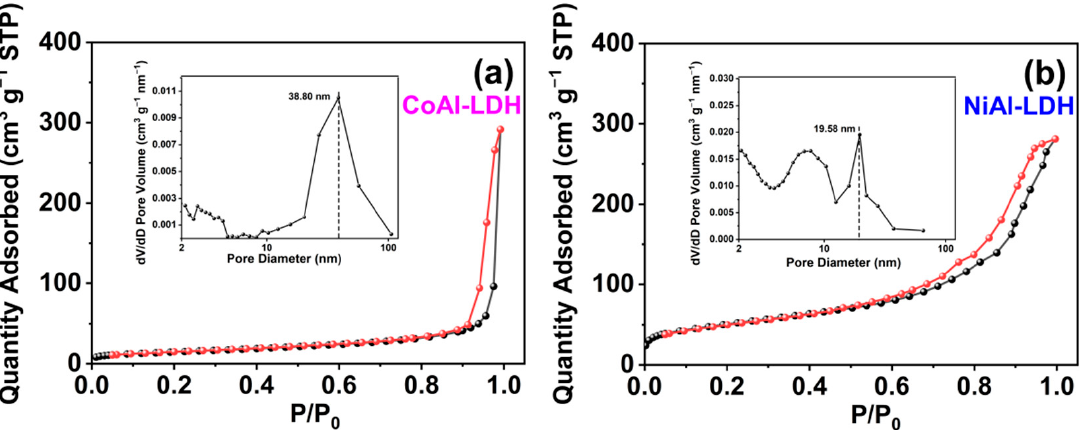
Figure 3. N 2 adsorption–desorption isotherms of ( a ) CoAl-LDH and ( b ) NiAl-LDH and the corre- sponding pore diameter distribution curves (insets).